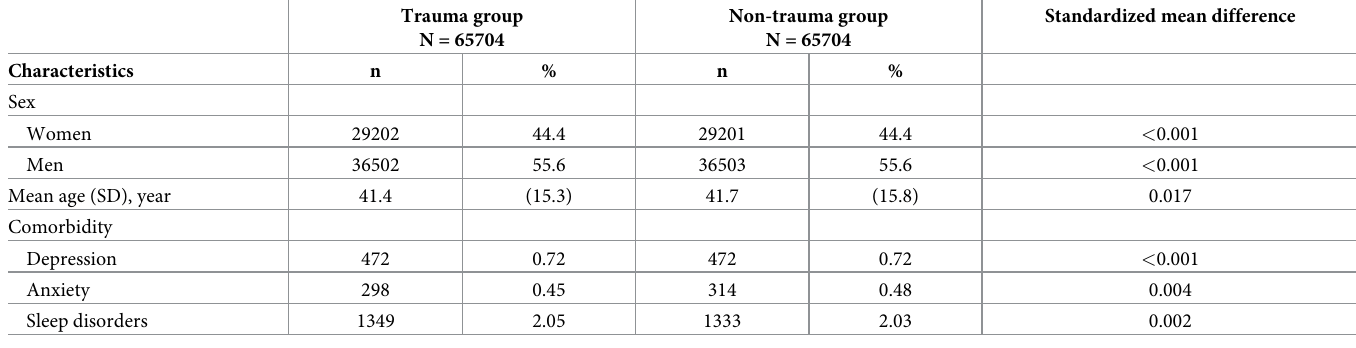
Table 1. Baseline demographic factors and comorbidity of study participants according to trauma